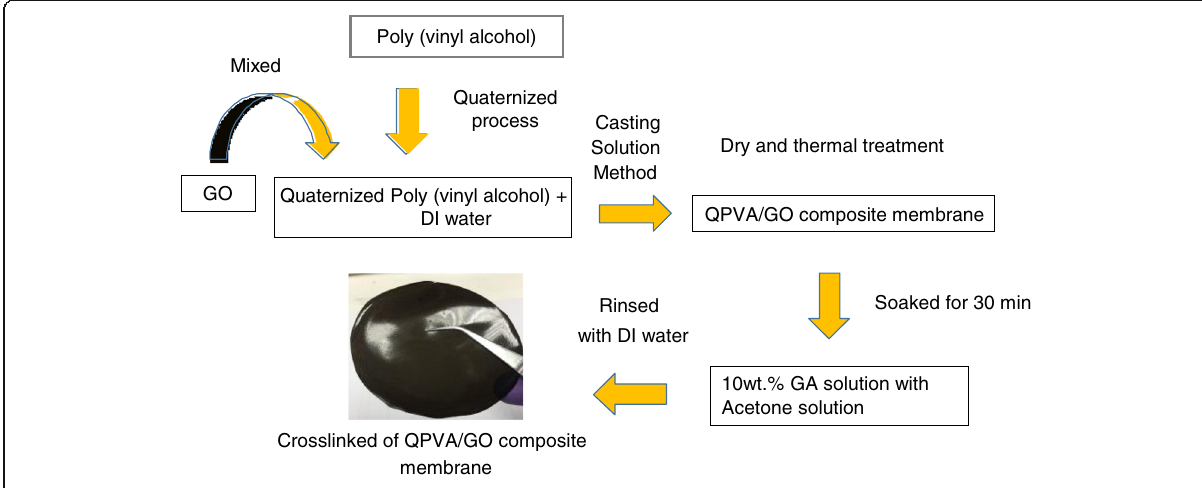
Fig. 1 Schematic diagram of the preparation of QPVA/GO composite